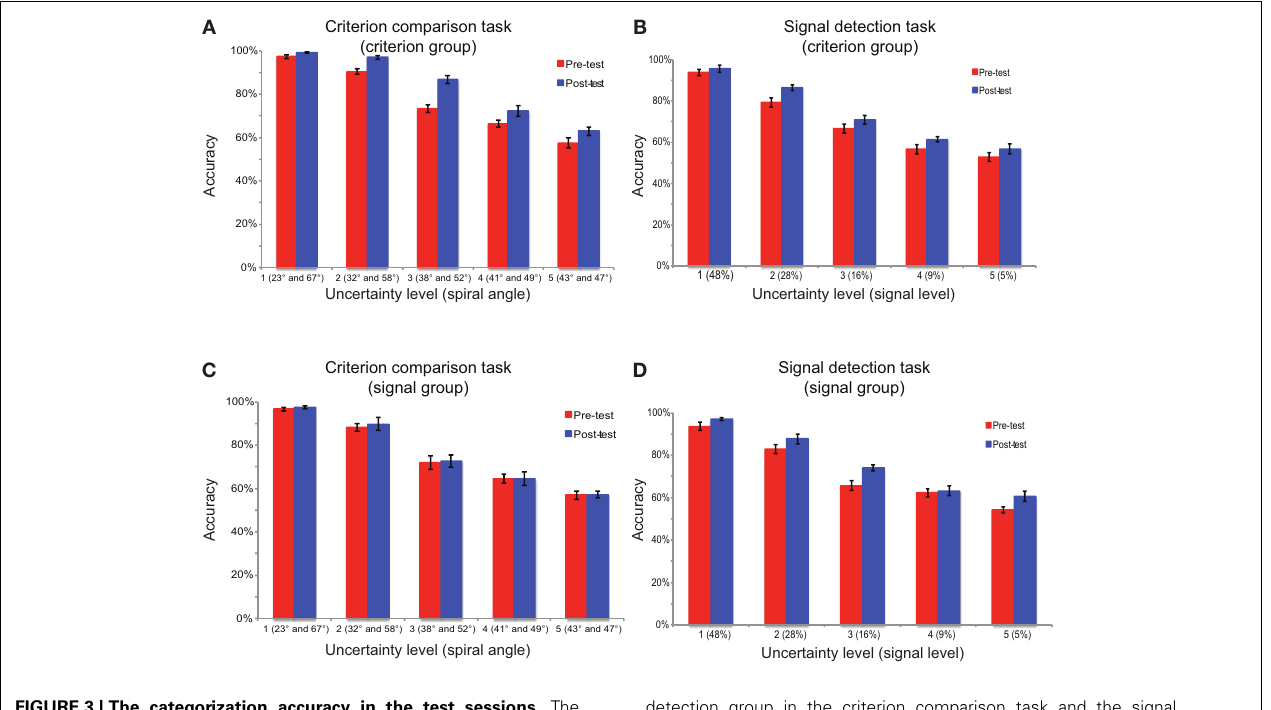
FIGURE 3 | The categorization accuracy in the test sessions. The performance is shown for (A) the criterion comparison group in the criterion comparison task and the signal detection task, (B) the signal